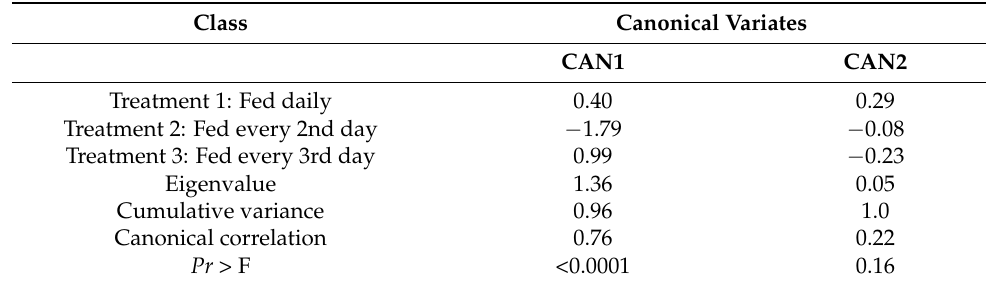
Table 7. Class means on the first two canonical variates based on the fatty acid composition of the northern Largemouth bass whole body samples of each class (Trial 2).